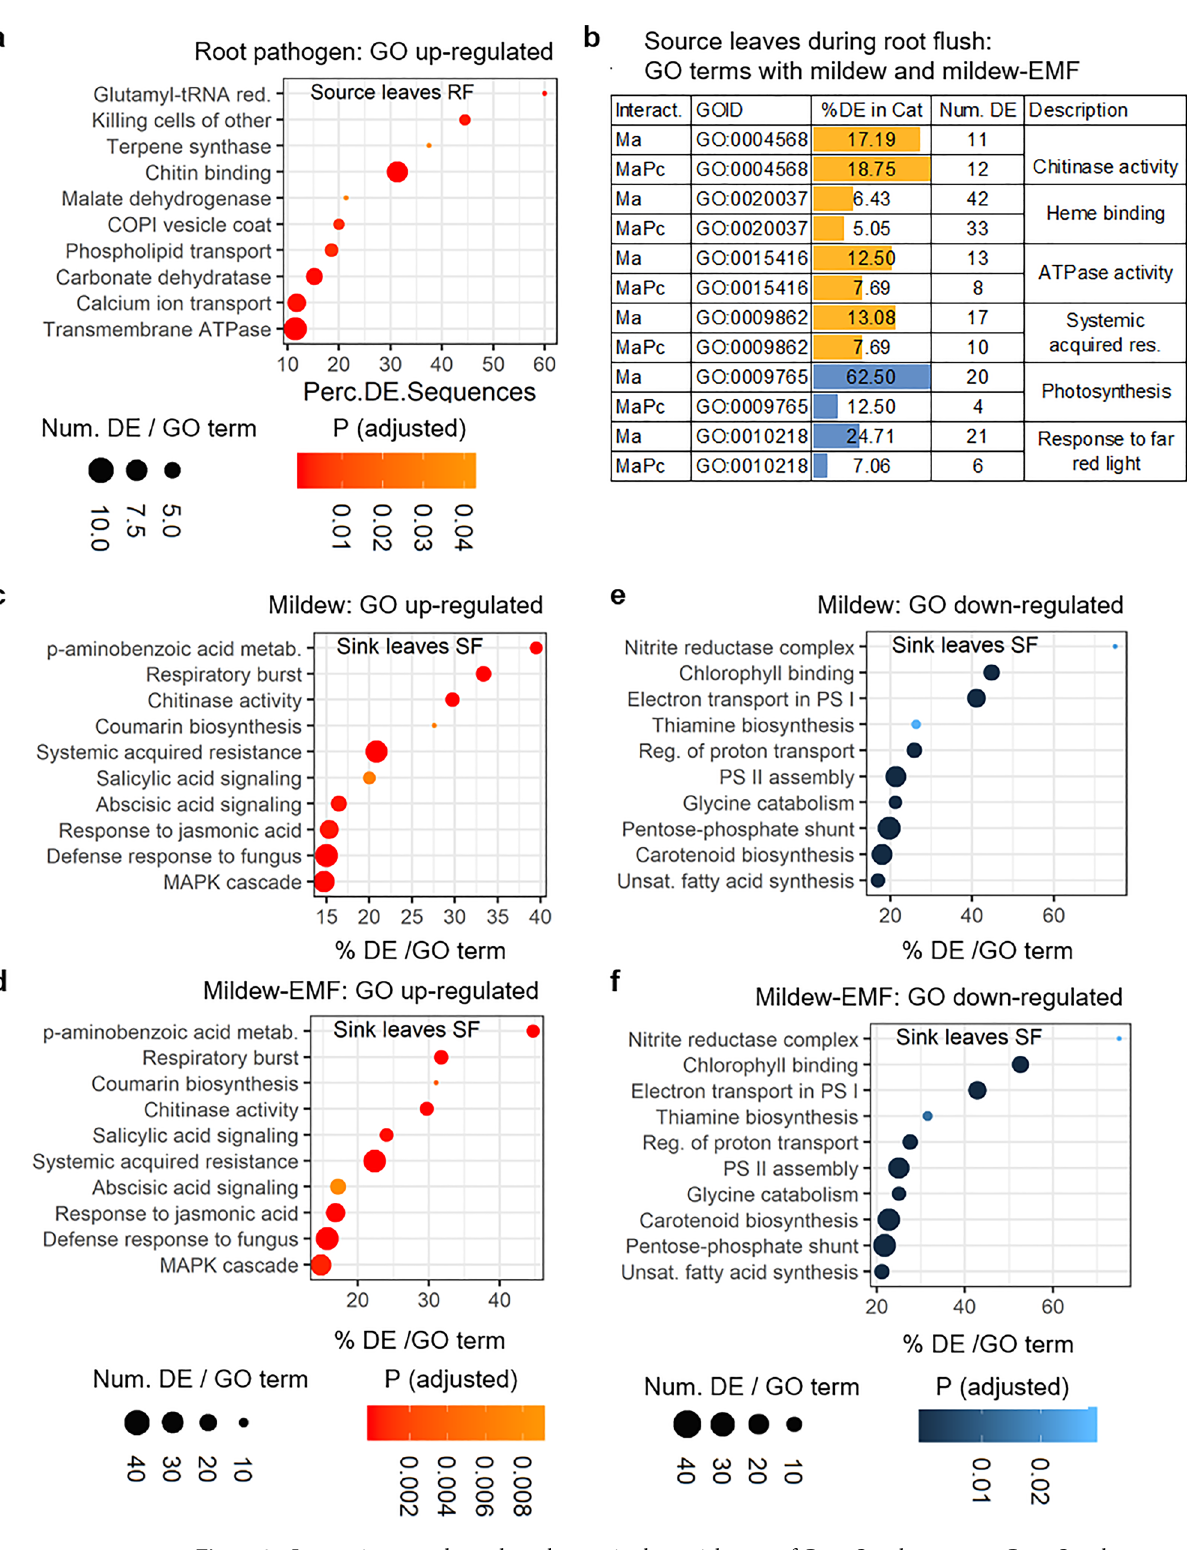
Figure 2. Interaction type dependent changes in the enrichment of Gene Ontology terms. Gene Ontology (GO) terms enriched in up- (orange) or down-regulated (blue) genes at the adjusted significance level of FDR < 0.05 from sink leaves during shoot flush (SF) and source leaves during root flush (RF). ( a ) Source leaves during RF with root pathogen (Pq) Phytophthora quercina and ( b ) with mildew (Ma) Microsphaera alphitoides or mildew and ectomycorrhizal fungus (EMF) Piloderma croceum . ( c, e ) Sink leaves during SF with mildew, and ( d, f ), with mildew and EMF. Dot plots visualise the enrichment level as the percentage of differentially expressed genes in a GO category (dot position) and as the level of significance (dot colour). Bars visualise the enrichment level as the percentage of differentially expressed sequences in a GO category (bar